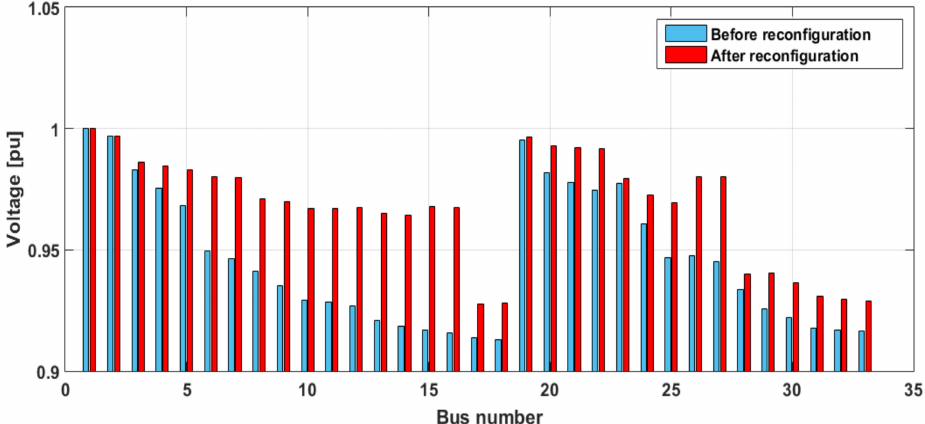
Figure 7. Voltage profiles for the minimization of the ENS criterion (before and after reconfiguration)).